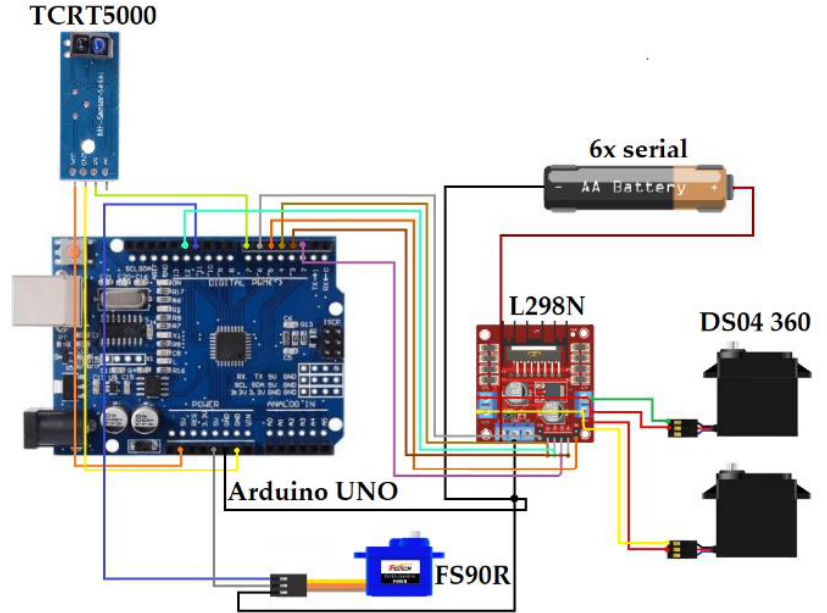
Figure 3. Arduino wiring diagram.